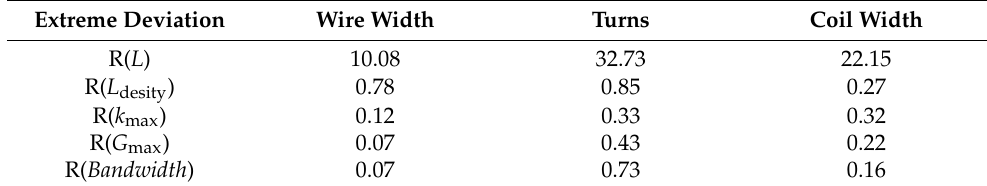
Table 5. Extreme deviation analysis of toroidal transformer with air